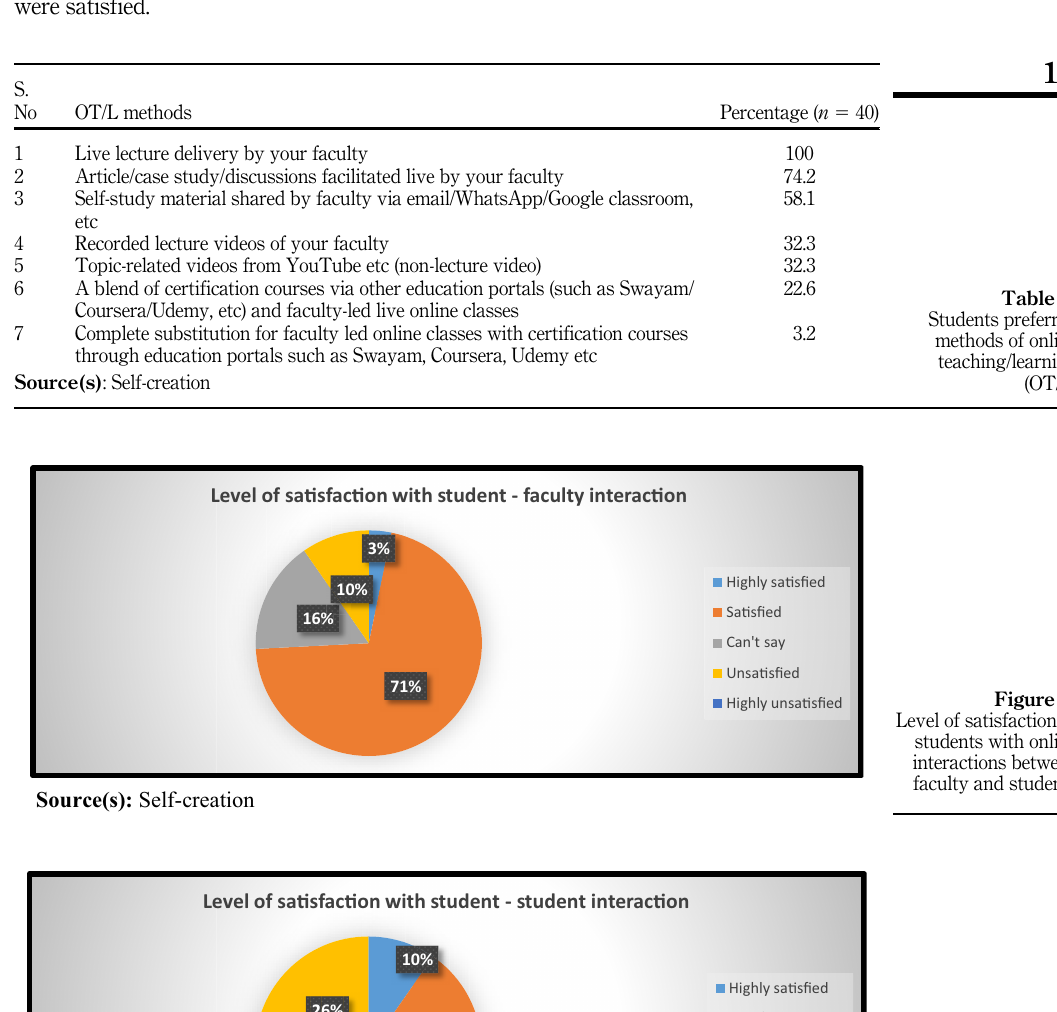
Figure 2. Level of satisfaction of students with online class interactions among students